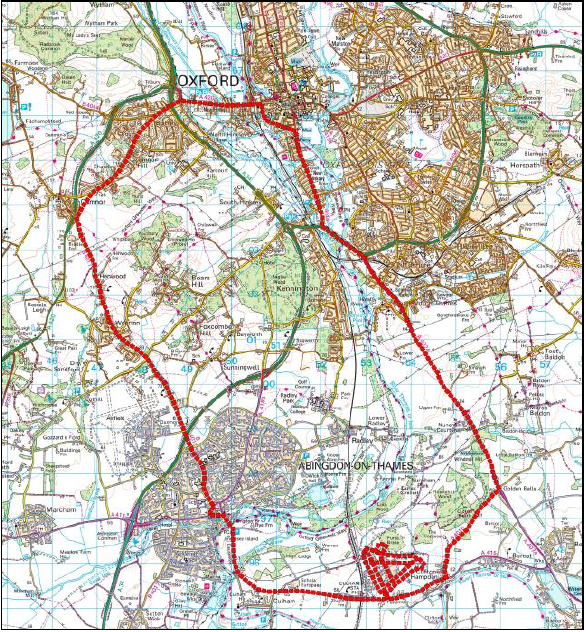
Figure 1. The OmniCAV route in Oxfordshire, UK Various point densities were experimented with, before a compromise resolution with a point-spacing of around 15 cm was chosen. Even this reduced resolution would be too dense for the simulator if applied to the whole scene, so a variable- resolution terrain model was created, using a high density on the road surface and a lower density (of around 2 m point spacing) in all other